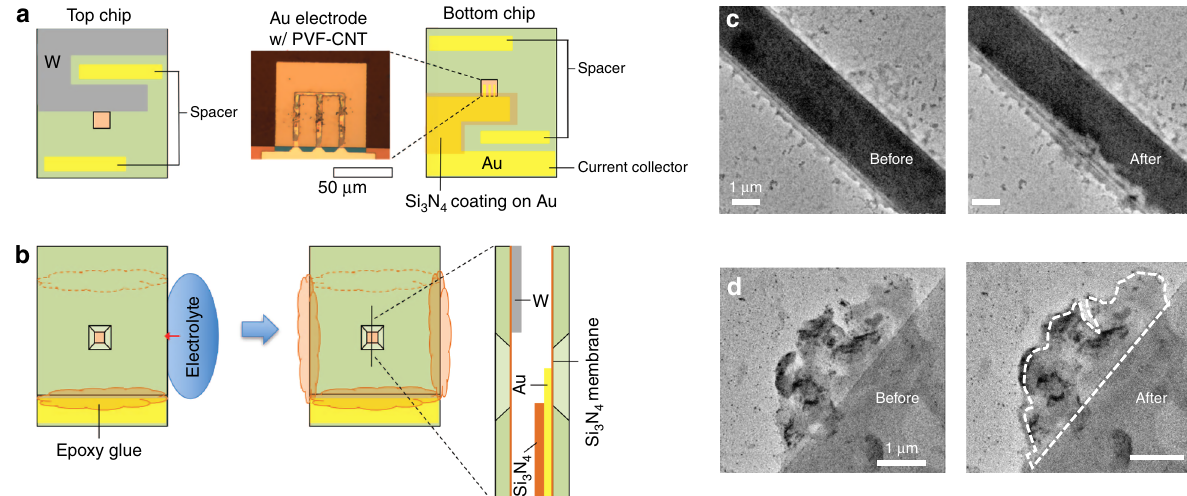
Fig. 4 In situ TEM investigation of the redox-active metallopolymer under electrochemical modulation. a Schematic illustration of the top and bottom chips for the liquid cell. The optical micrograph image shows the PVF fi lm deposited on the Au electrode patterned on the Si 3 N 4 membrane window. b Chip assembly process. The two chips were overlapped and the two sides of the perimeter sealed with epoxy glue. The electrolyte was contacted with the side opening and injected into the cell via the capillary effect. A magni fi ed cross-sectional view at the windows is illustrated. Detailed fabrication procedures for each component are given elsewhere 34 , with the polymer electrodeposition process described in Methods. c In situ TEM micrograph of PVF layer on top of gold chip. A solution of 20 mM NaClO 4 was introduced and a CV @ 0.1 V/s was applied to the two-electrode system; a clear expansion of the PVF fi lm can be seen following ion insertion (Supplementary Movie 1). d Swelling and contrast change of a PVF fi lm under electrochemical modulation in the presence